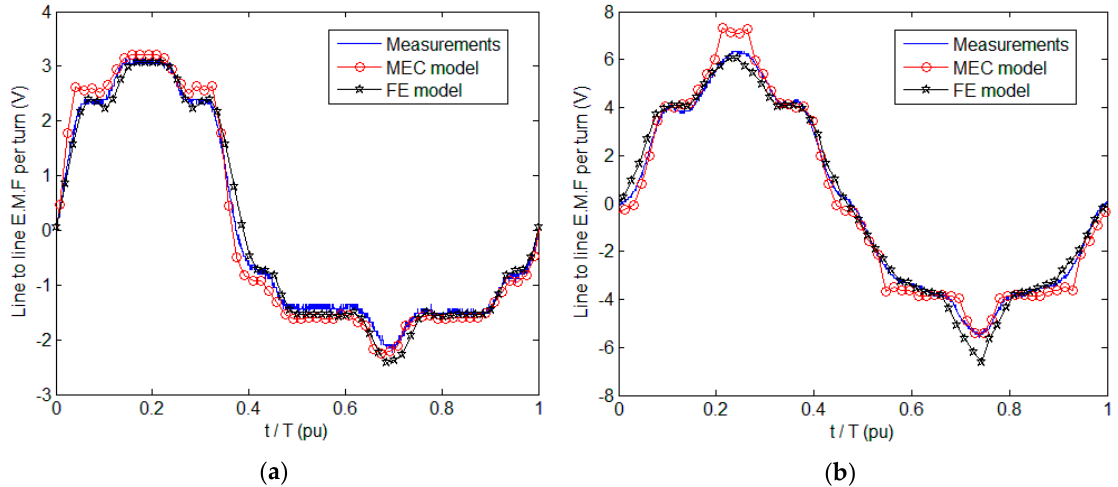
Figure 28. Open-circuit line-to-line EMF per-turn. ( a ) For I exc = − 4 A; ( b ) for I exc = + 4 A.